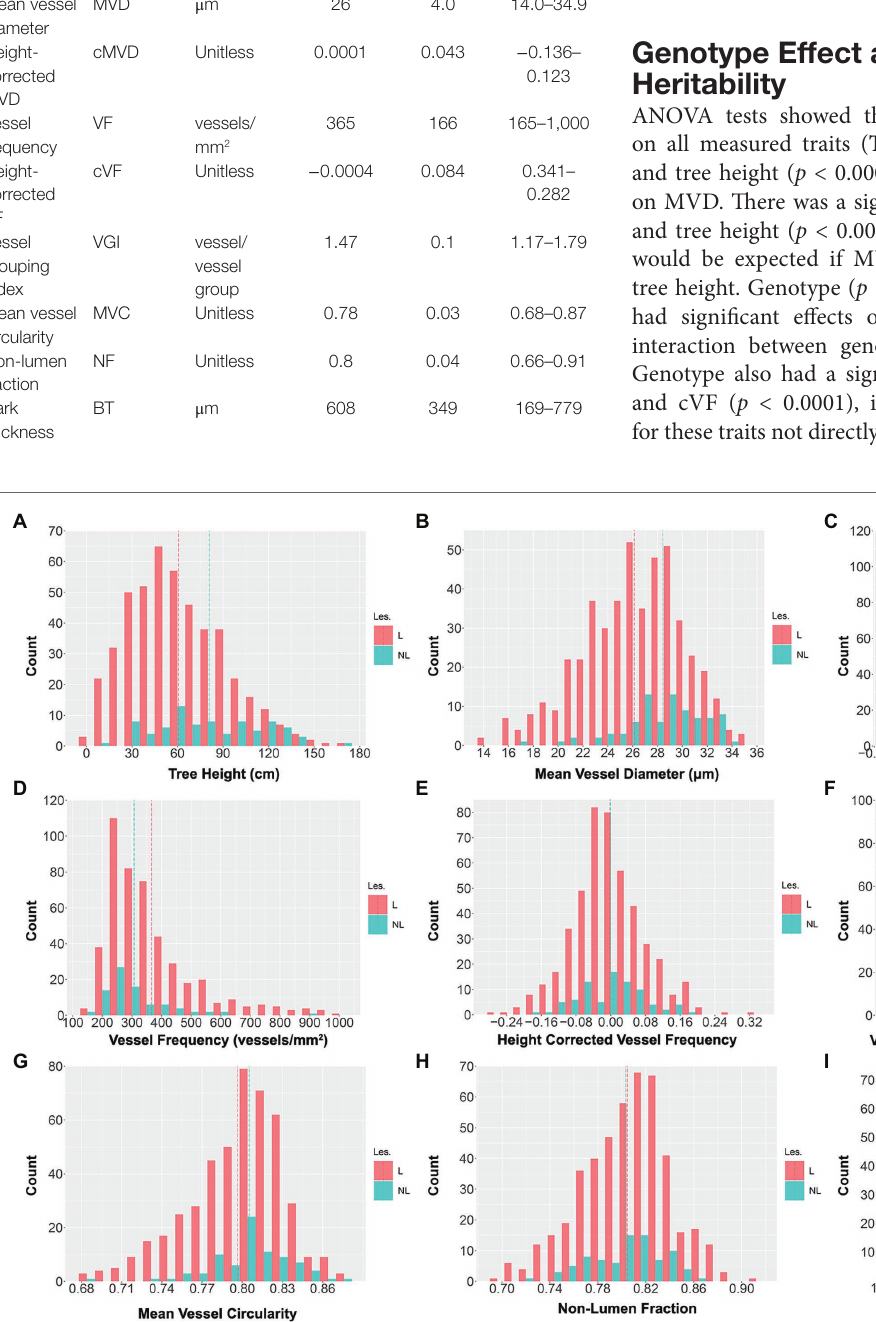
FIGURE 3 | Untransformed wood anatomical trait and stem trait data distributions across the 201 genotypes included in the study. Values are for three clonal replicates per genotype. The red bars represent indel genotypes (173), and the blue bars represent non-lesion genotypes (28). Traits include tree height (TH; A ), mean vessel diameter (MVD; B ), height-corrected mean vessel diameter (cMVD; C ), vessel frequency (VF; D ), height-corrected vessel frequency (cVF; E ), vessel grouping index (VGI; F ), mean vessel circularity (MVC; G ), non-lumen fraction (NF; H ), and bark thickness (BT; I ). The red dotted lines represent the trait means of indel lines, and the blue dotted lines represent the trait means of non-indel lines.